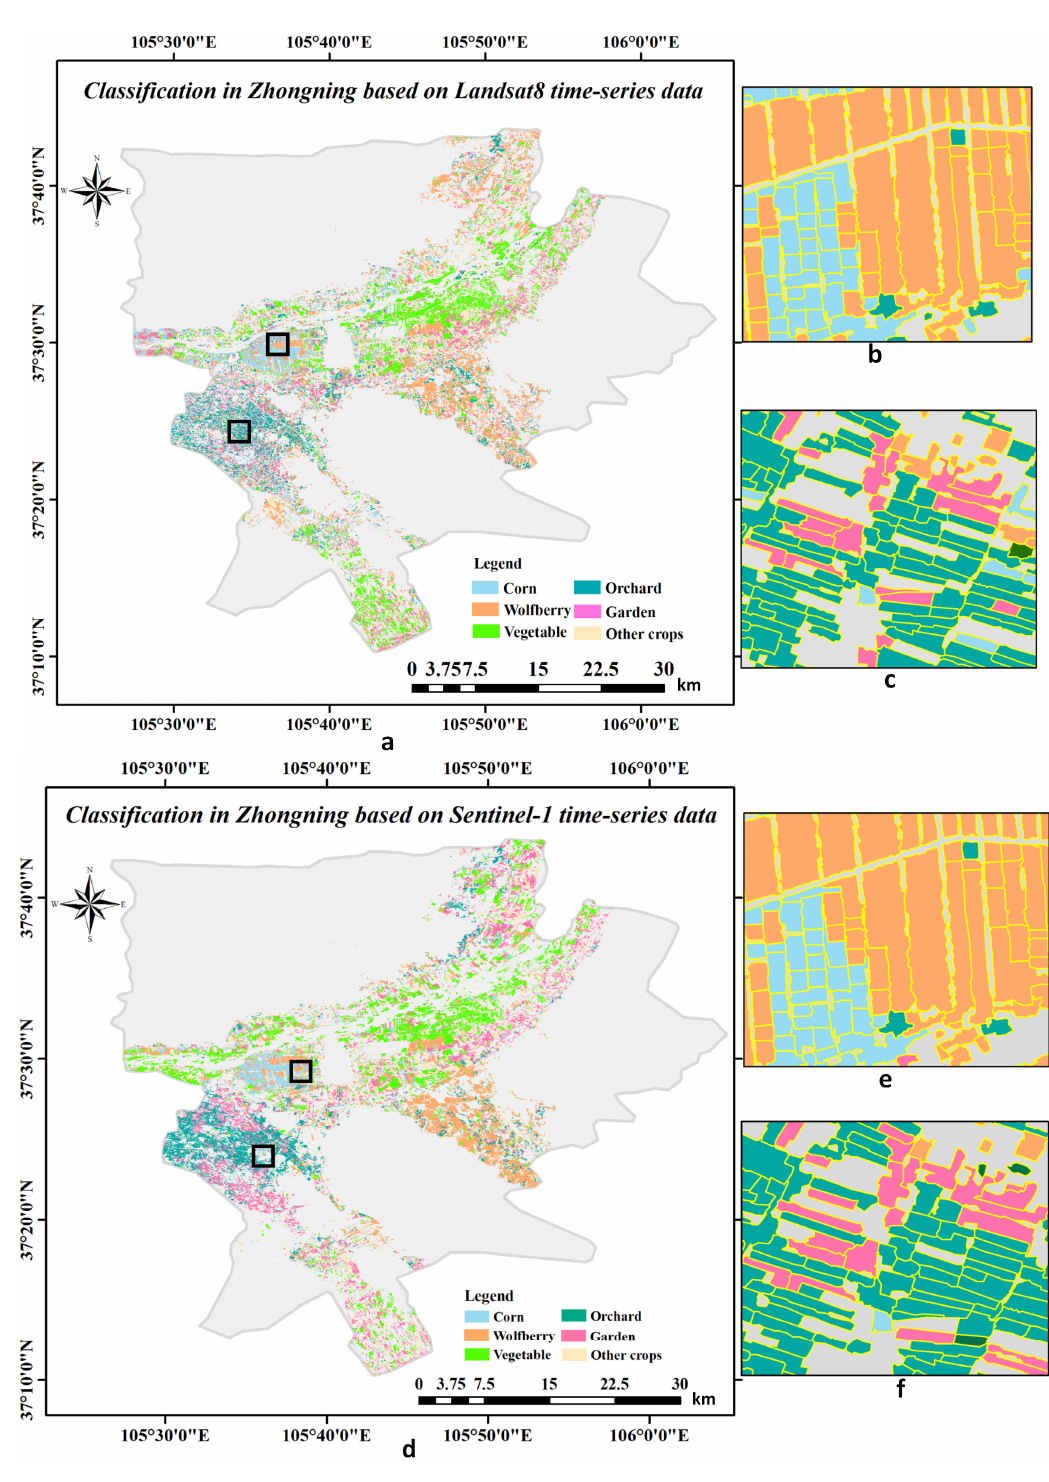
Figure 7. Crop classification based on Landsat-8 and Sentinel-1 datasets: ( a ) classification results based on Landsat-8 time-series data; ( b ) classification results based on Sentinel-1 time-series data; ( c ), ( d ), ( e ), and ( f ) are the enlarged figures of the black boxes in (a) and (d).